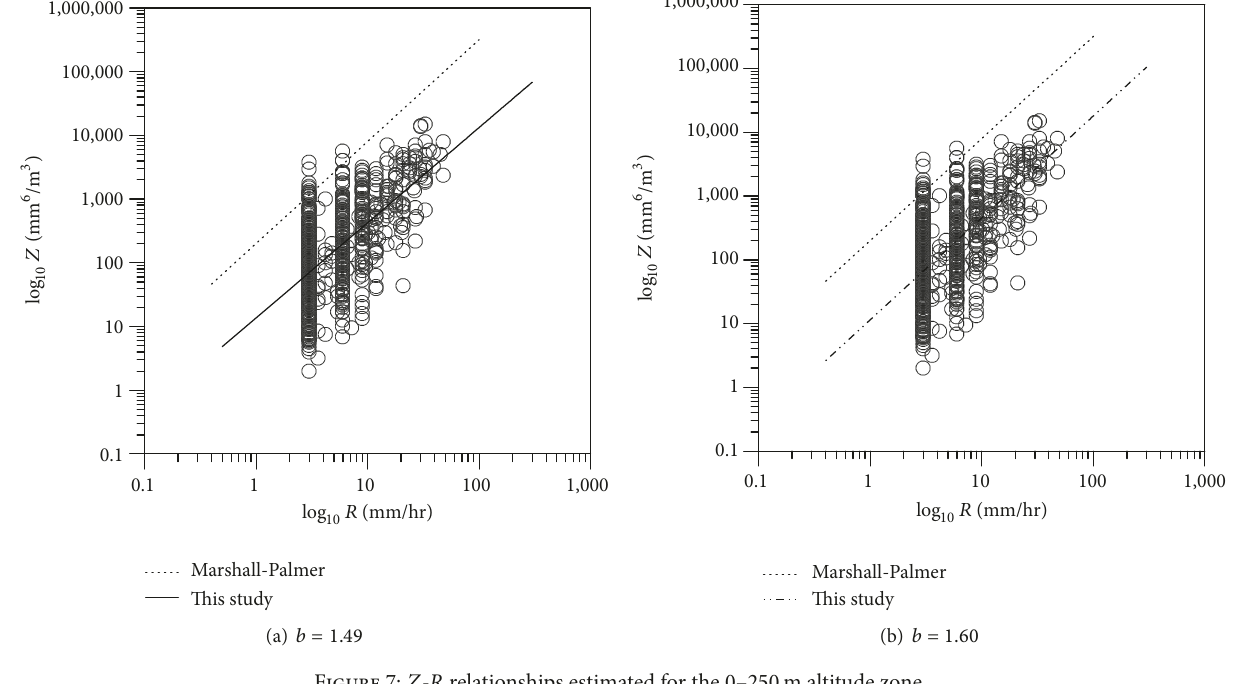
Figure 7: 𝑍 - 𝑅 relationships estimated for the 0–250 m altitude zone.